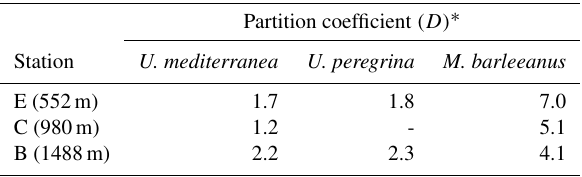
Table 6. Manganese pore water–carbonate partition coefficient for foraminiferal species Uvigerina mediterranea , Uvigerina pereg- rina , and Melonis barleeanus